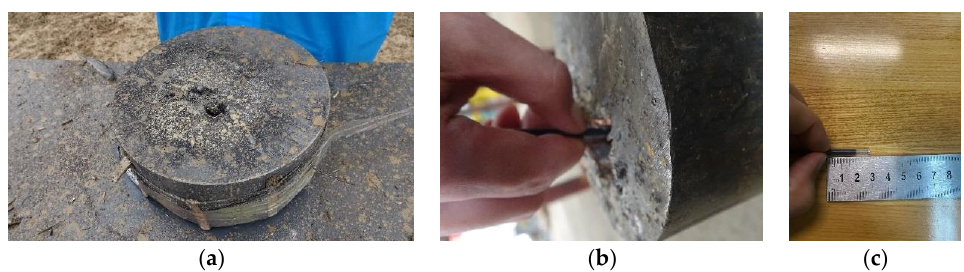
Figure 13. Simulated cabin residual.